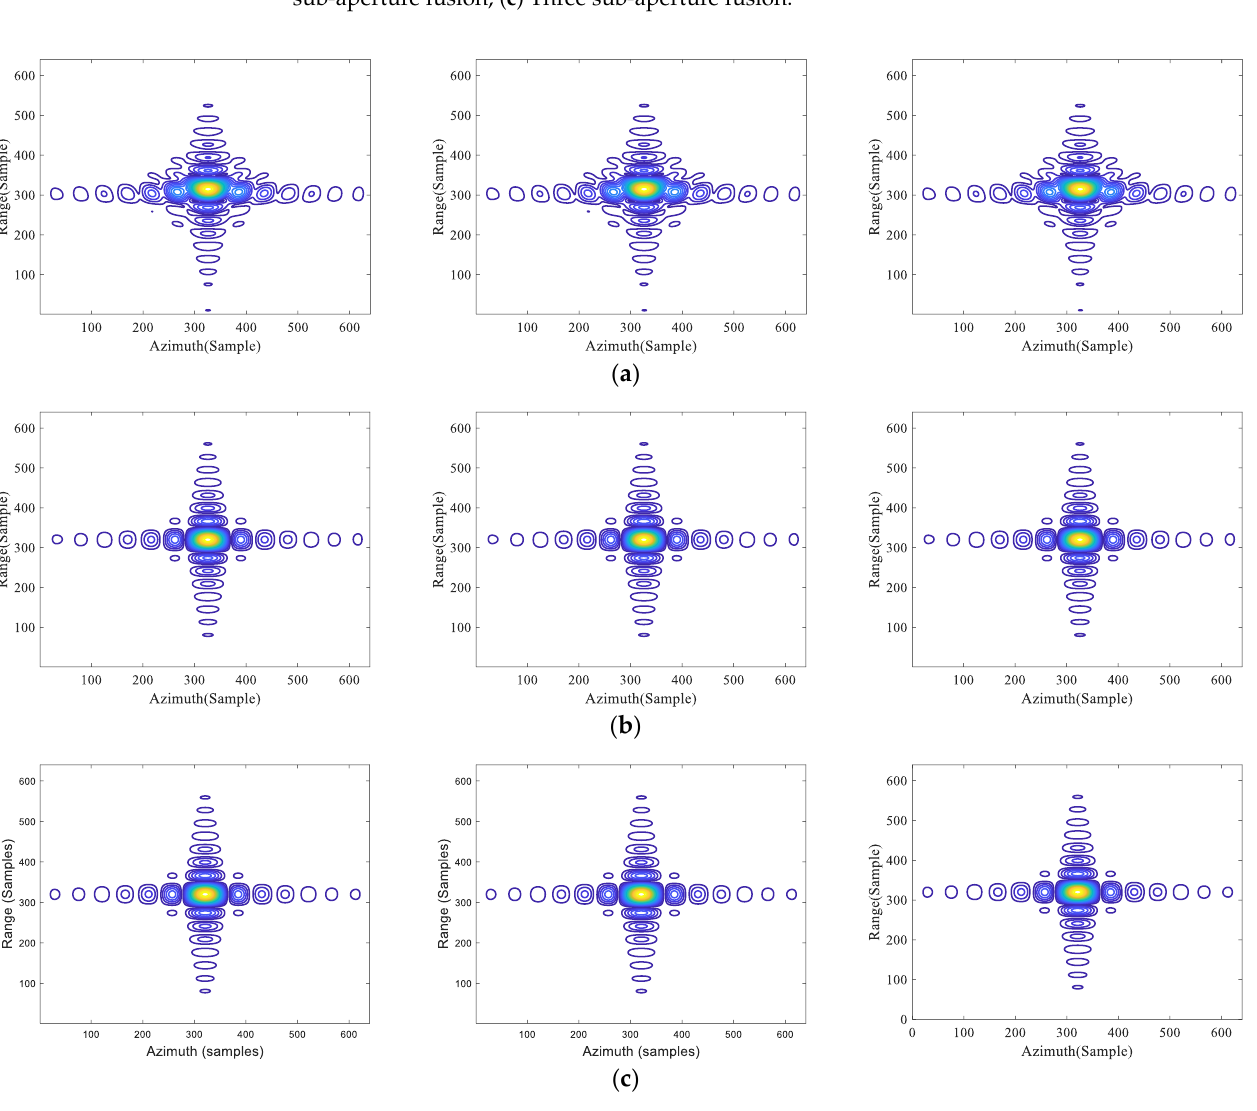
Figure 12. Comparative results of targets PT3, PT4, and PT5. ( a ) The traditional RDA; ( b ) The proposed method with segmented RCMC; ( c )